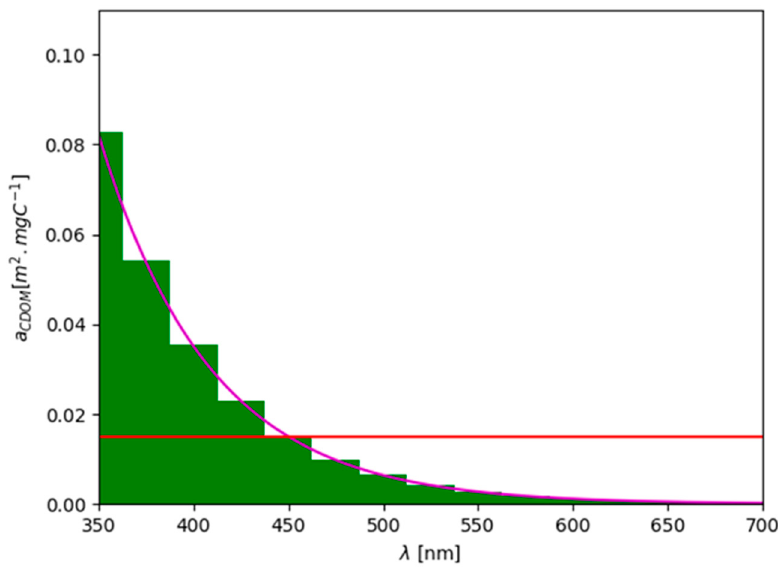
Figure 3. Carbon normalized spectral absorption curve of CDOM averaged over model spectral bins (green histograms). Reference absorption at 450 nm is marked with the red horizontal line.